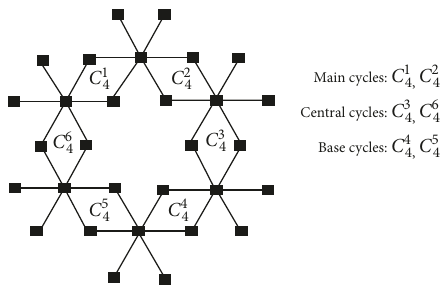
Figure 1: Unit cell (bismuth tri-iodide).